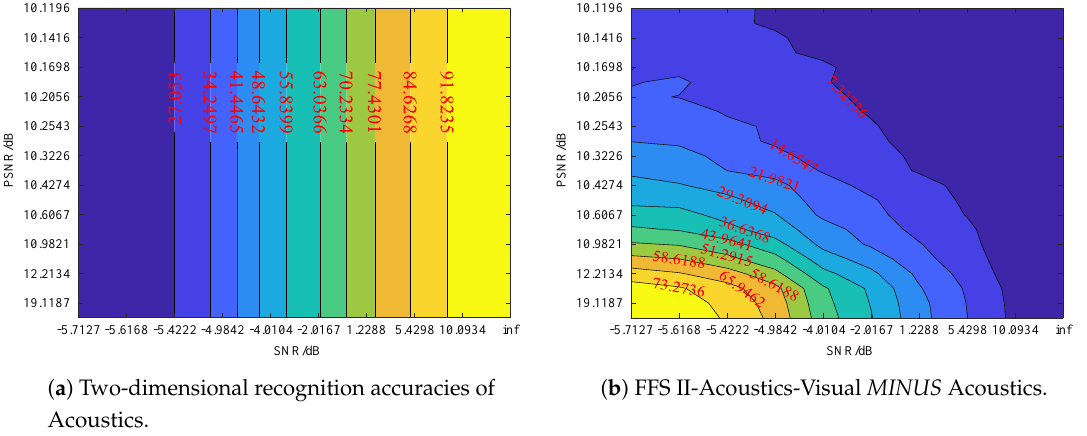
Figure 7. The comparison between Acoustics and FFS II-Acoustics-Visual.